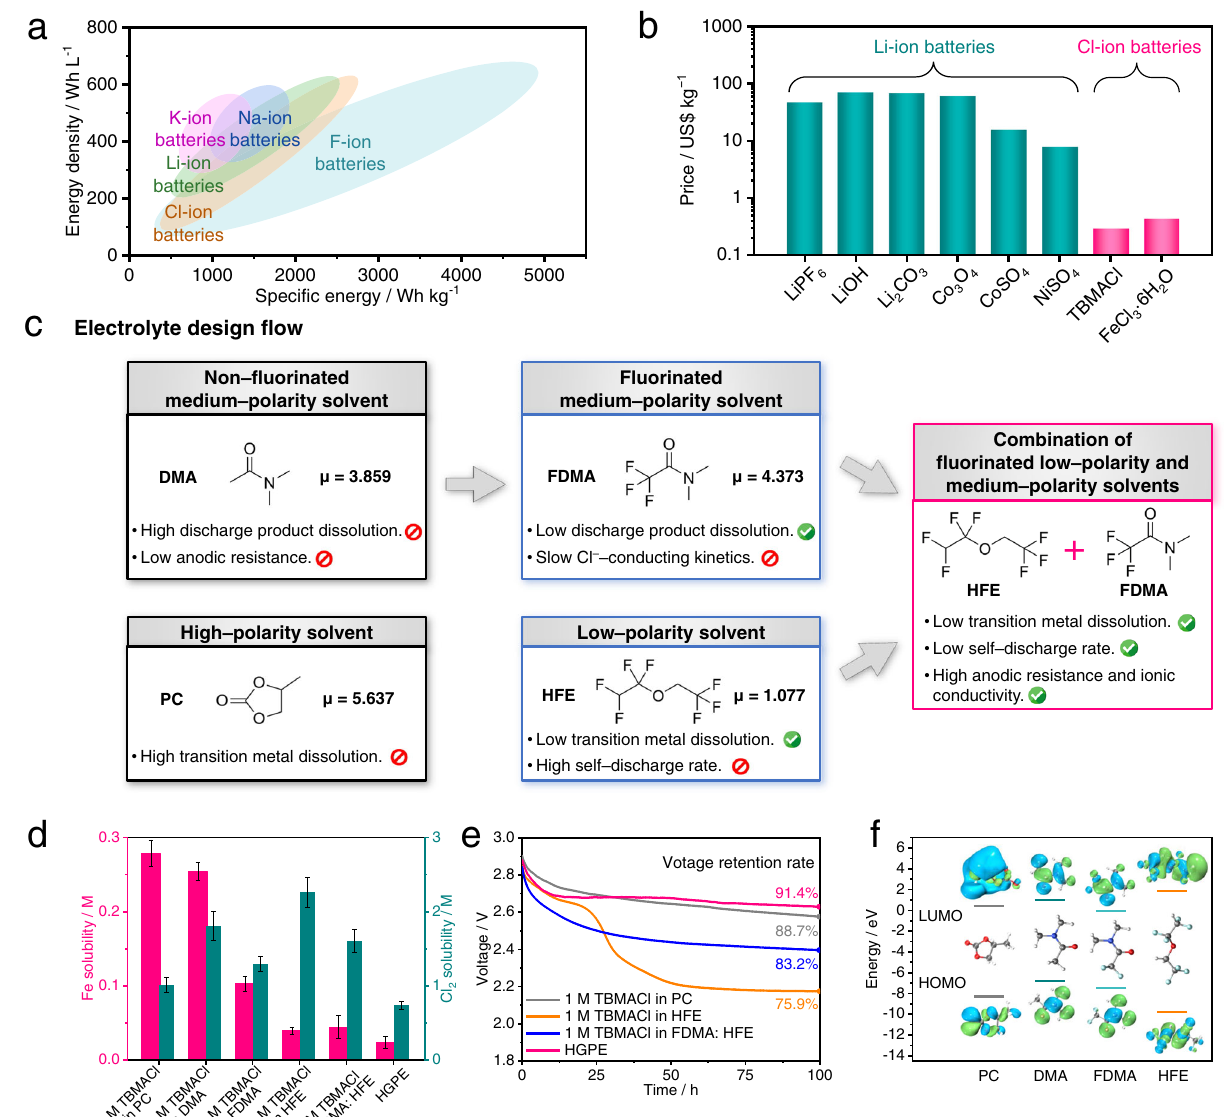
Fig. 1 | Electrolyte screening for CIBs. a Comparison of the theoretical energy densityandspeci fi cenergyofLi – ,Na – ,K – ,F – ,andCl-ionbatteries.Thetheoretical speci fi c energies are calculated based on the total mass of the anode and cathode active materials. b Price of raw materials for Li – and Cl-ion batteries. c Schematic representation of the molecular strategy used for the development of CIB binary non-aqueouselectrolytesolvents. μ isthedipolemoment. d FeandCl 2 solubilityin